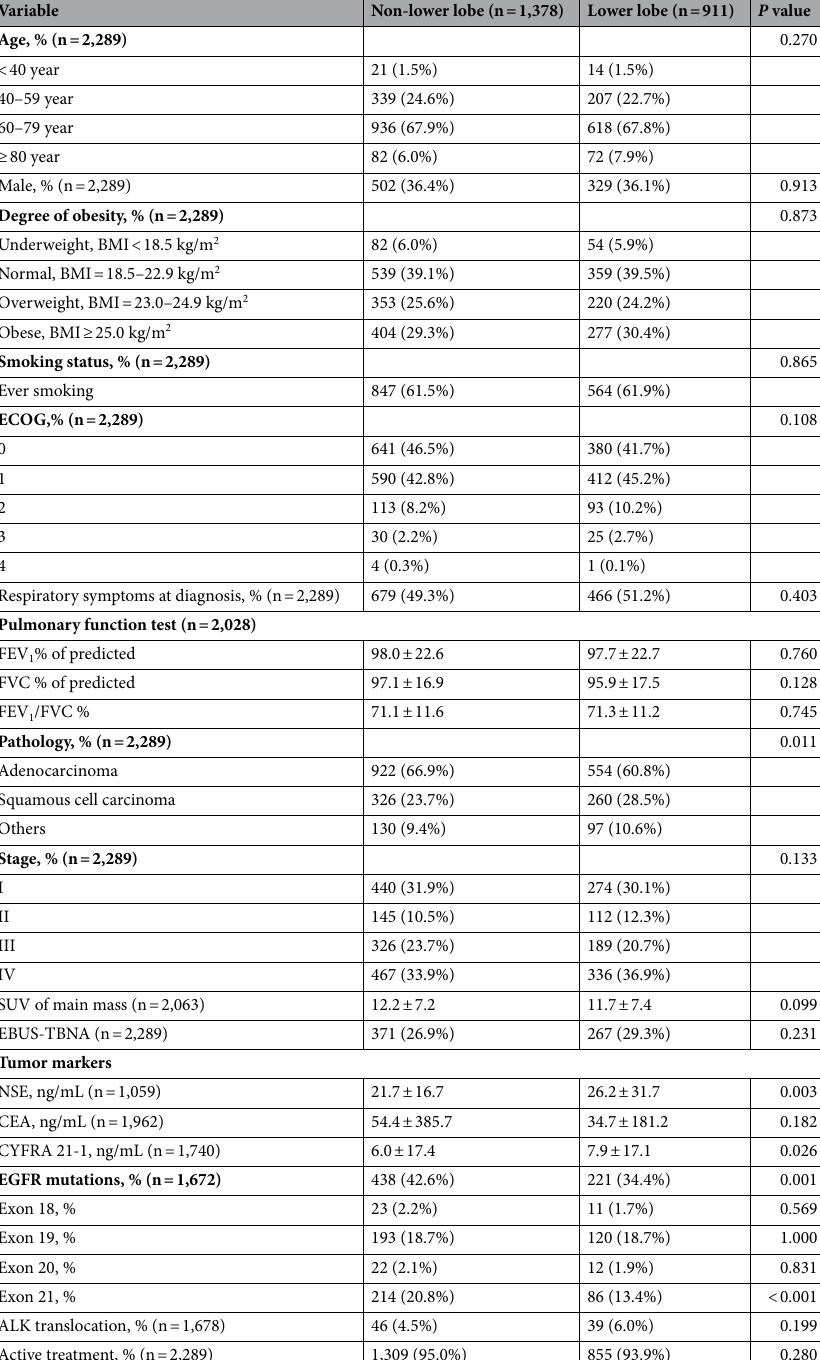
Table 1. Baseline characteristics according to tumor location of non-small cell lung cancer patients. ALK anaplastic lymphoma kinase; BMI body mass index; CEA carcinoembryonic antigen; CYFRA cytokeratin fragment; EBUS-TBNA endobronchial ultrasound-guided transbronchial needle aspirate; ECOG Eastern Cooperative Oncology Group; EGFR epidermal growth factor receptor; FEV1 forced expiratory volume in 1 second; FVC forced vital capacity; NSE neuron-specific enolase; SUV standardized uptake